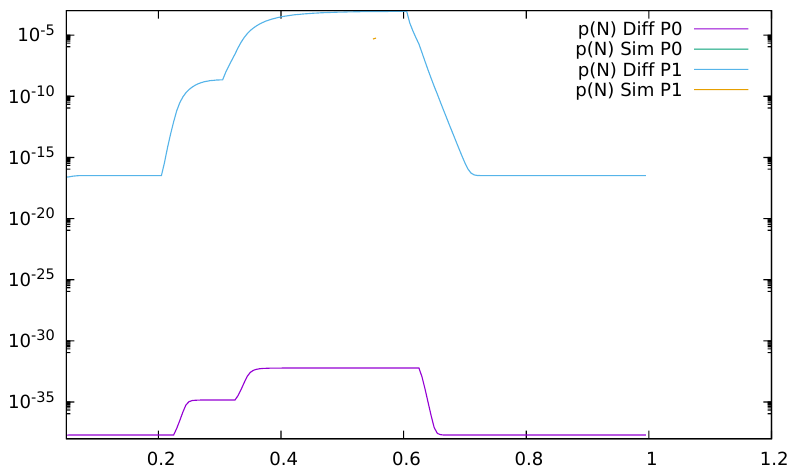
Figure 29. Loss probability due to the queue saturation as a function of time, (cid:101) = 0.2, diffusion, and simulation